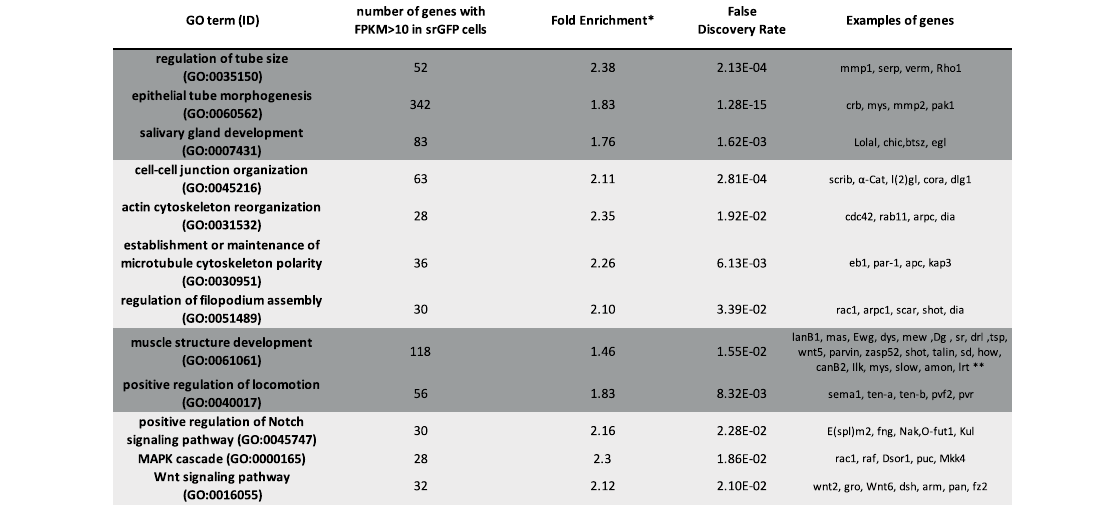
TABLE 1 | List of over-represented GO from RNAseq analysis of sr-gal4 > UAS-GFP cells.